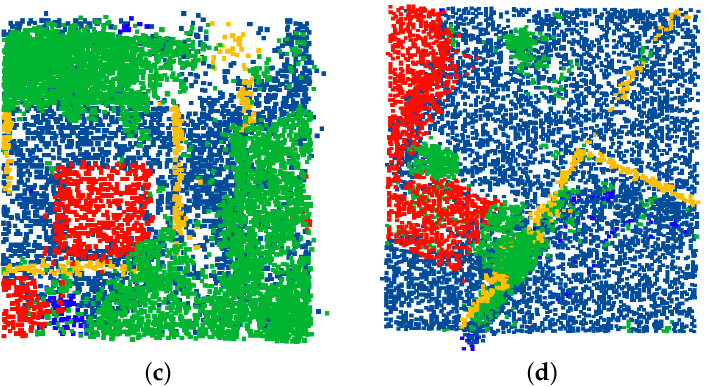
Figure 14. These images show examples of the scenes from Dataset 2. Dataset 2 contains the initial occluded input point clouds and our generated points. These have been combined and then run through a semantic segmentation network. Each scene has 18,882 total points with eight classes. Each point is labeled by object category: ground (blue), vegetation (dark green), power lines (yellow), poles (dark orange), buildings (red), fences (light orange), trucks (light green), cars (light green), unknown (dark blue).